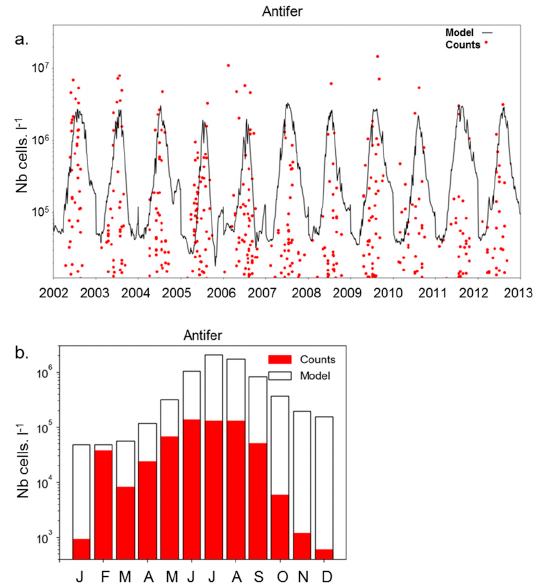
Figure 7. (a ) Inter-annual variations in Pseudo-nitzschia abundance at Antifer over the 2002–2012 period. ( b ) Average seasonal cycle of abundance from Pseudo-nitzschia over the same period. (Observed REPHY counts in red; ECO-MARS3D-simulated biomass converted into abundance following Hagström et al.